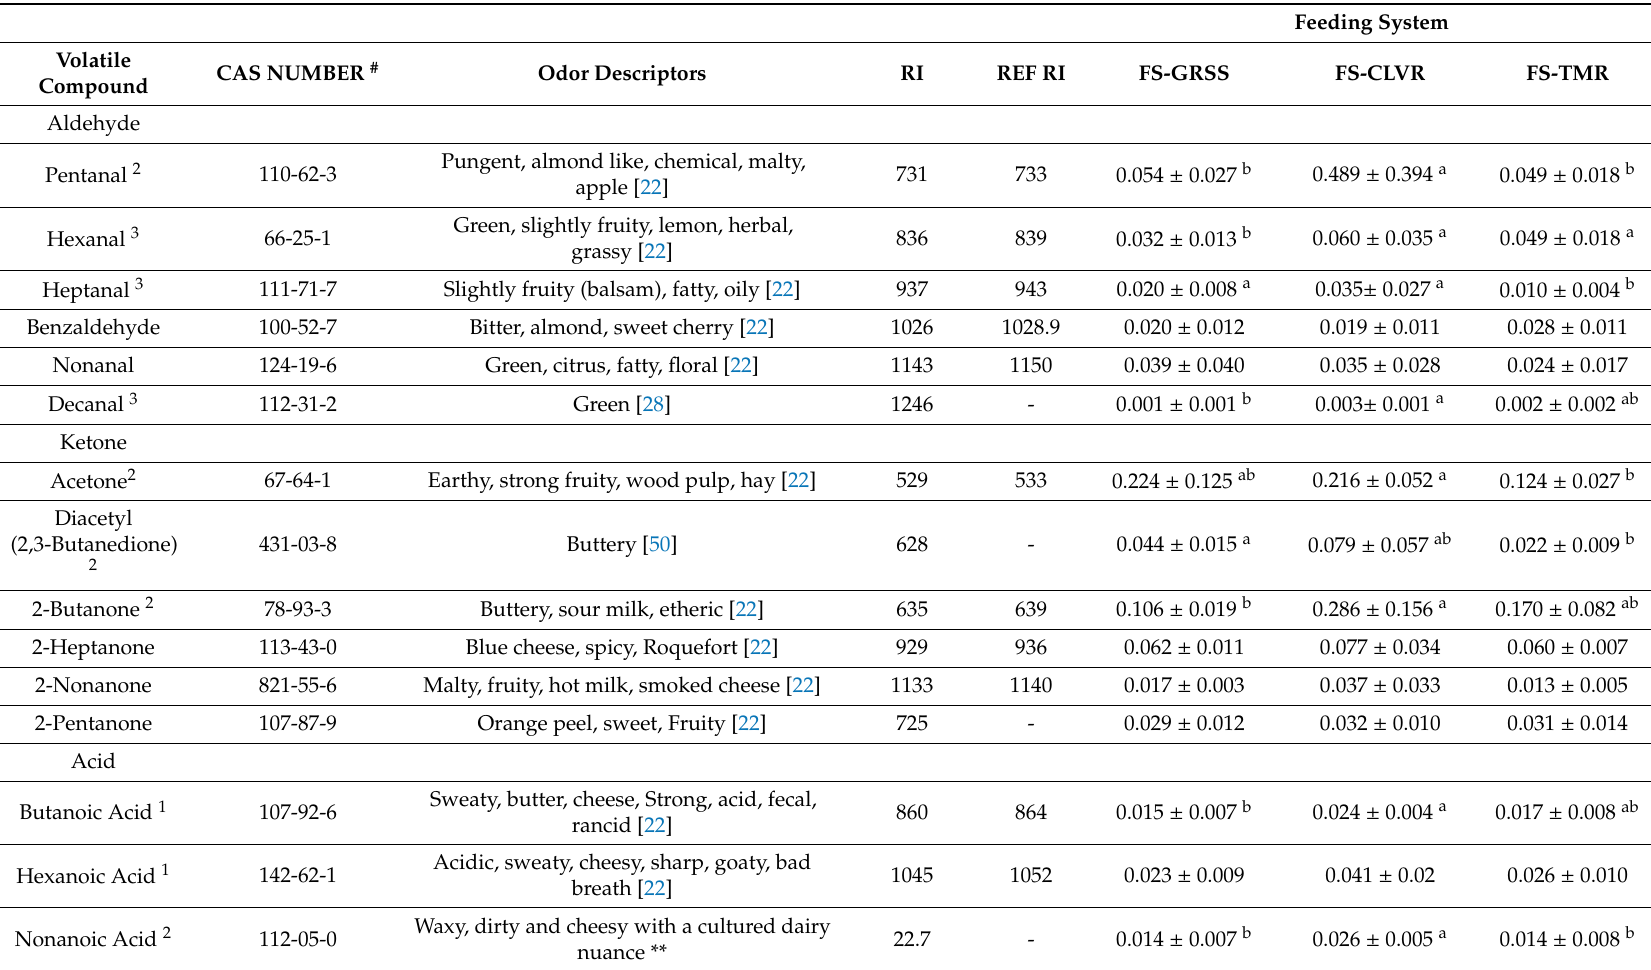
Table 4. Average ( n = 9) peak area values ( × 10 6 ) of volatile compounds identified in FS-GRSS, FS-CLVR and FS-TMR butters.